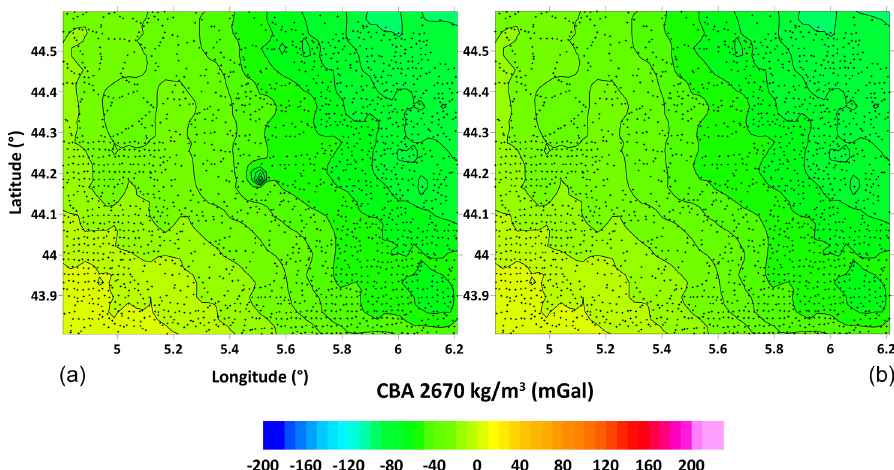
Figure 17. Example of an extreme value of more than 60mGal deviation in the new CBA map: initial CBA version (a) and final CBA version (b) . Small black markers represent data points.